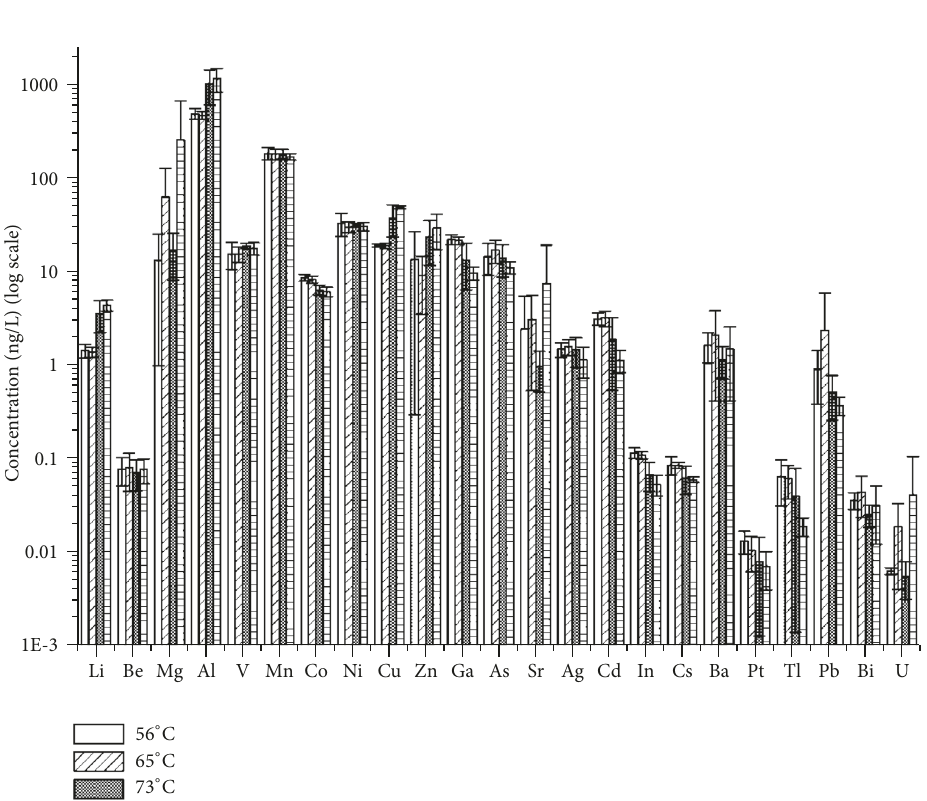
Figure 2: Effect of the subboiling temperature on trace element concentrations in HNO 3 (one distillation). Error bars correspond to ± 1 standard deviation based on the four analyzed